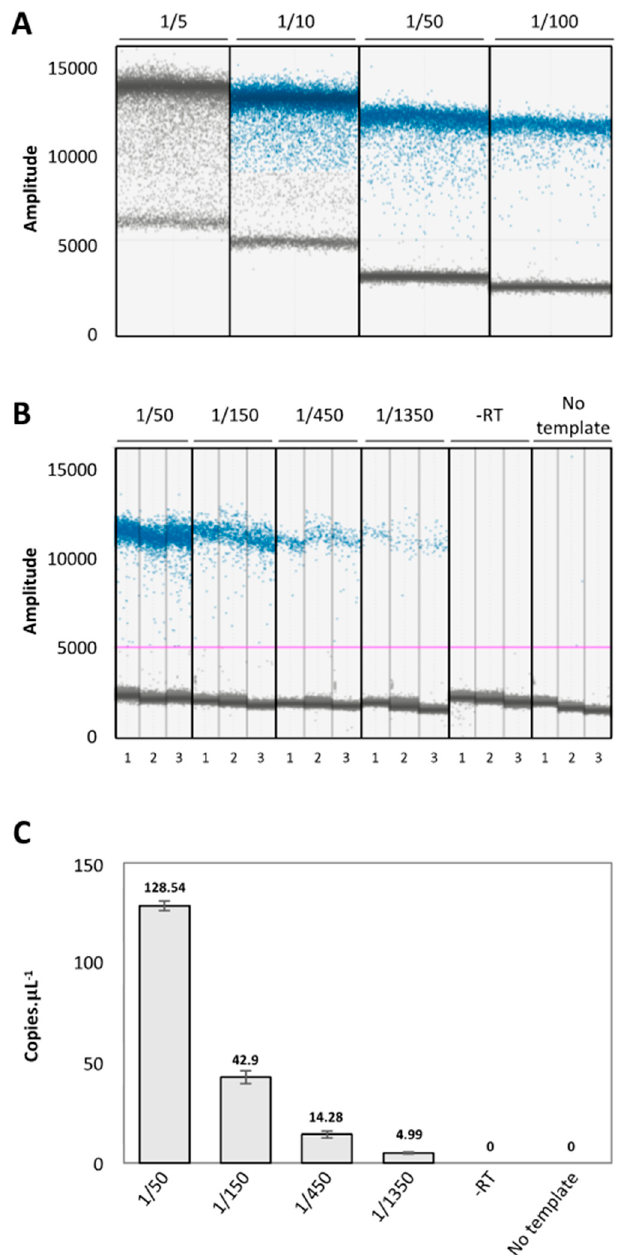
Figure 1. The importance of cDNA dilution for ddPCR quantification. ( A ). A ddPCR amplitude plot for At1G13245 according to the cDNA dilution factor. ( B ). A ddPCR amplitude plot for At1G13245 according to the cDNA dilution factor in each replicate. The blue and grey dots correspond, respec- tively, to the positive and negative droplets. The pink line corresponds to the threshold. ( C ). The number of copies per µ L obtained in B. N = 3. Mean ± SD. The mean value is indicated on each bar.